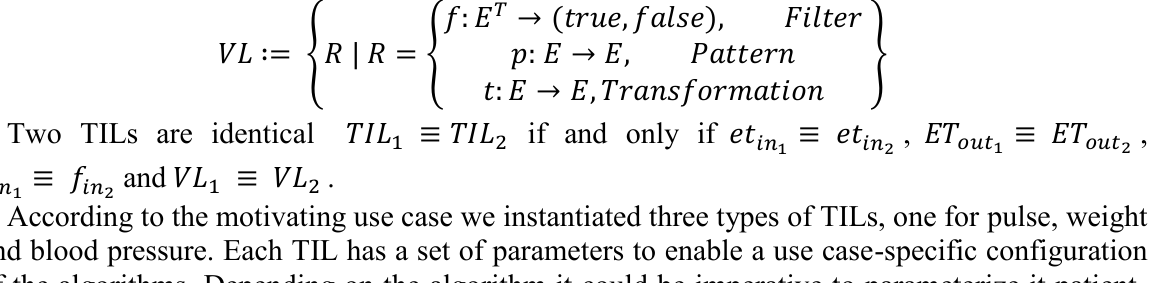
Starting at the bottom we have some kind of vital sign sensors from different